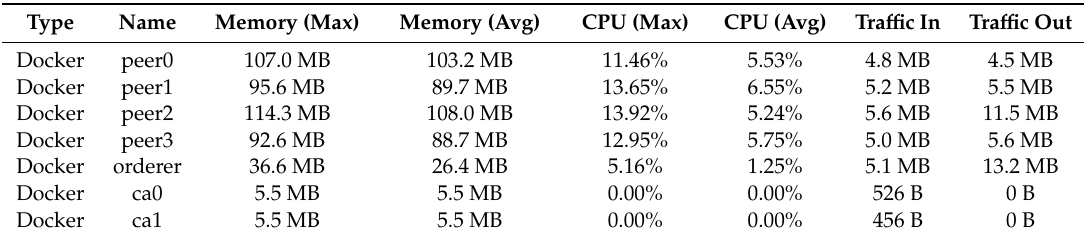
Table 4. Resource utilization evaluation of the blockchain